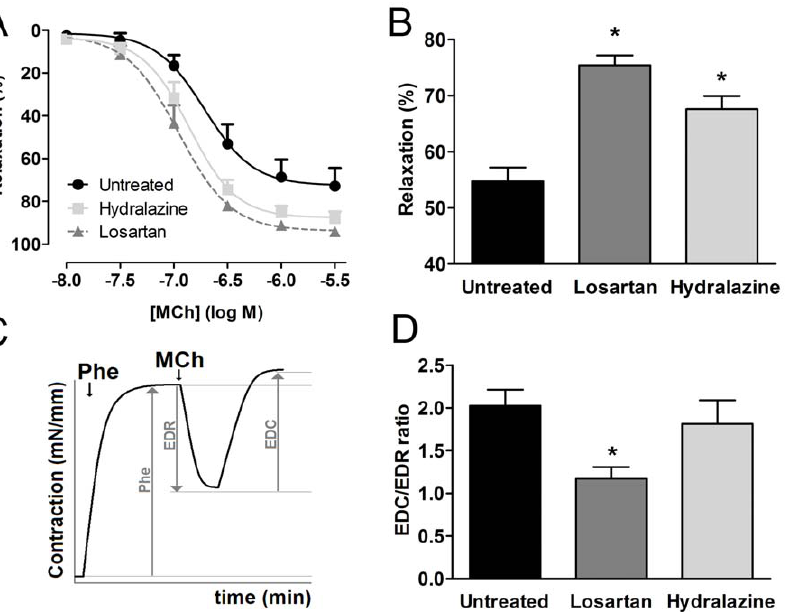
Figure 3. Losartan and hydralazine improve endothelial function in isolated carotid arteries of SHR. ( A ) Concentration-response-curve of methacholine-induced relaxation on phenylephrine pre-constriction. ( B ) Maximal relaxation potential after the addition of a single concentration (10 m M) of methacholine on phenylephrine-induced pre-constriction. ( C ) Schematic representation of a SHR carotid artery response towards a single 10 m M methacholine (MCh) addition on phenylephrine (Phe) precontraction resulting in endothelium-derived relaxation (EDR) and subsequent an additional endothelium-derived contraction (EDC). ( D ) Quantification of the normalized EDC/EDR ratio after 10 m M methacholine addition on phenylephrine pre-contraction as depicted in C. Data are expressed as mean 6 SEM, n=7–8, * p , 0.05 compared to untreated